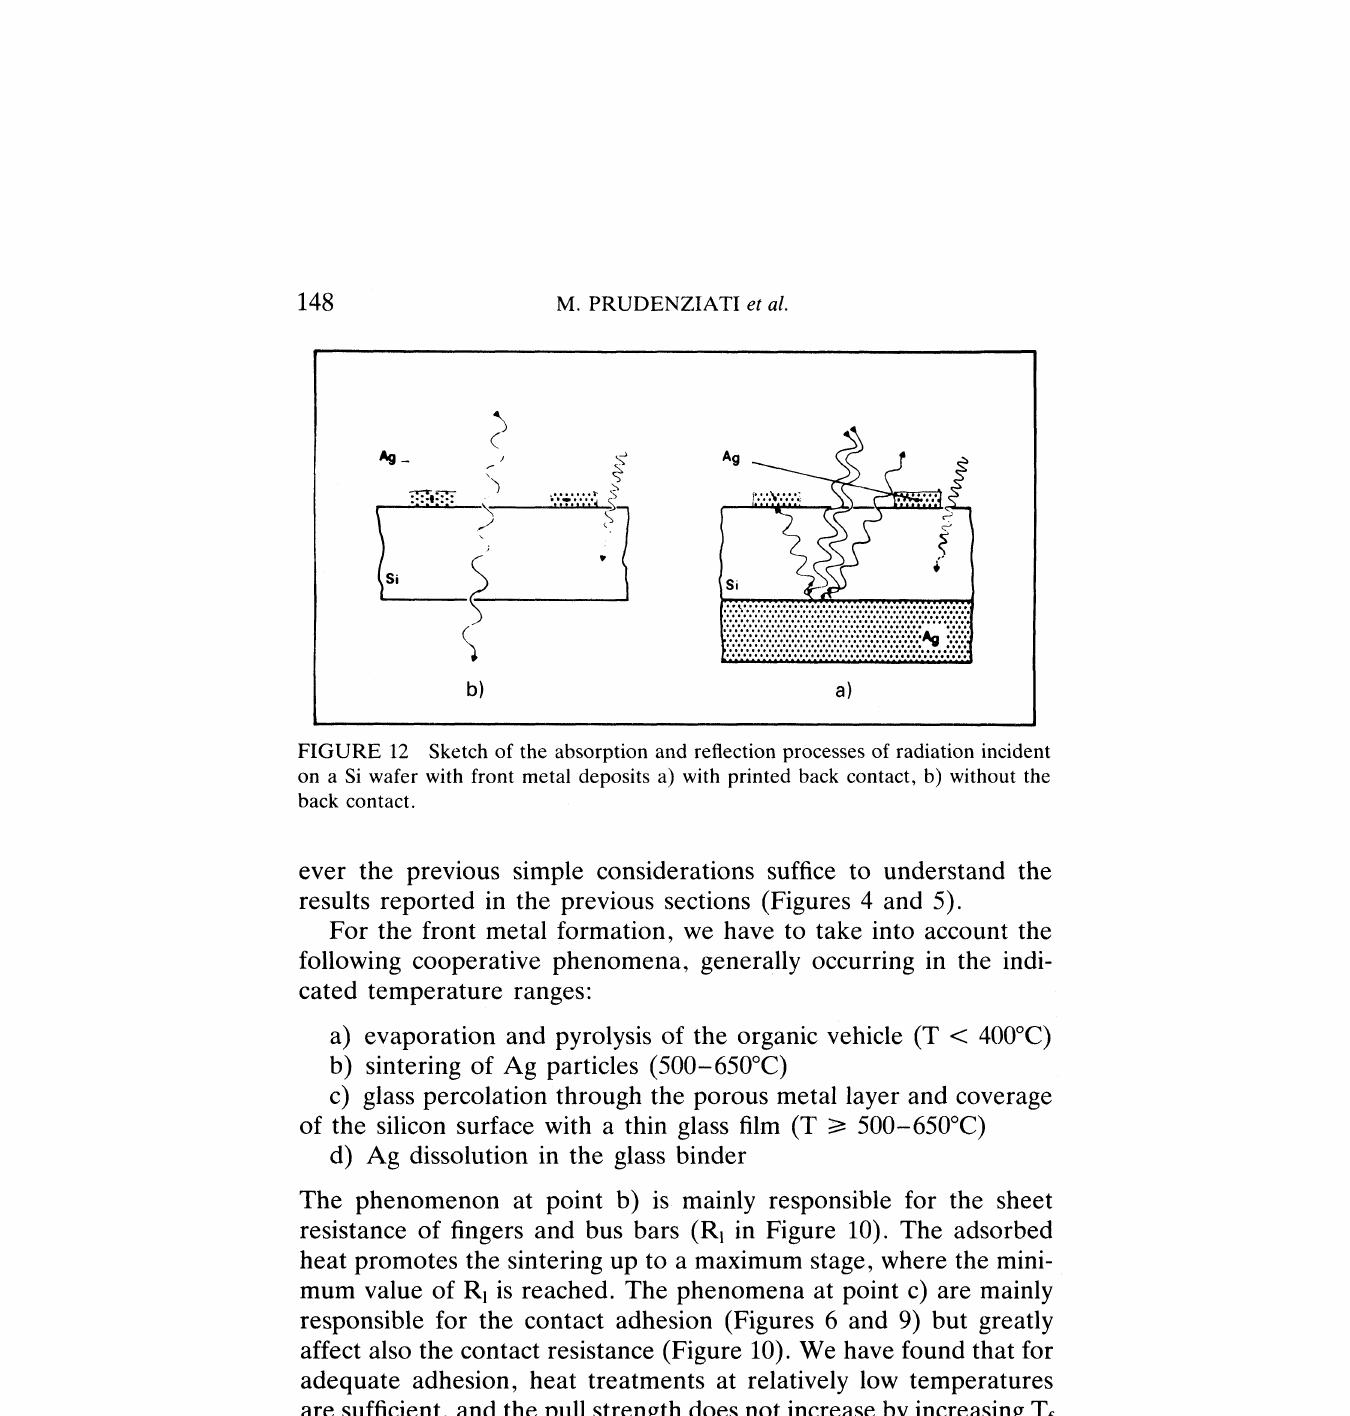
FIGURE 12 Sketch of the absorption and reflection processes of radiation incident on a Si wafer with front metal deposits a) with printed back contact, b) without the back